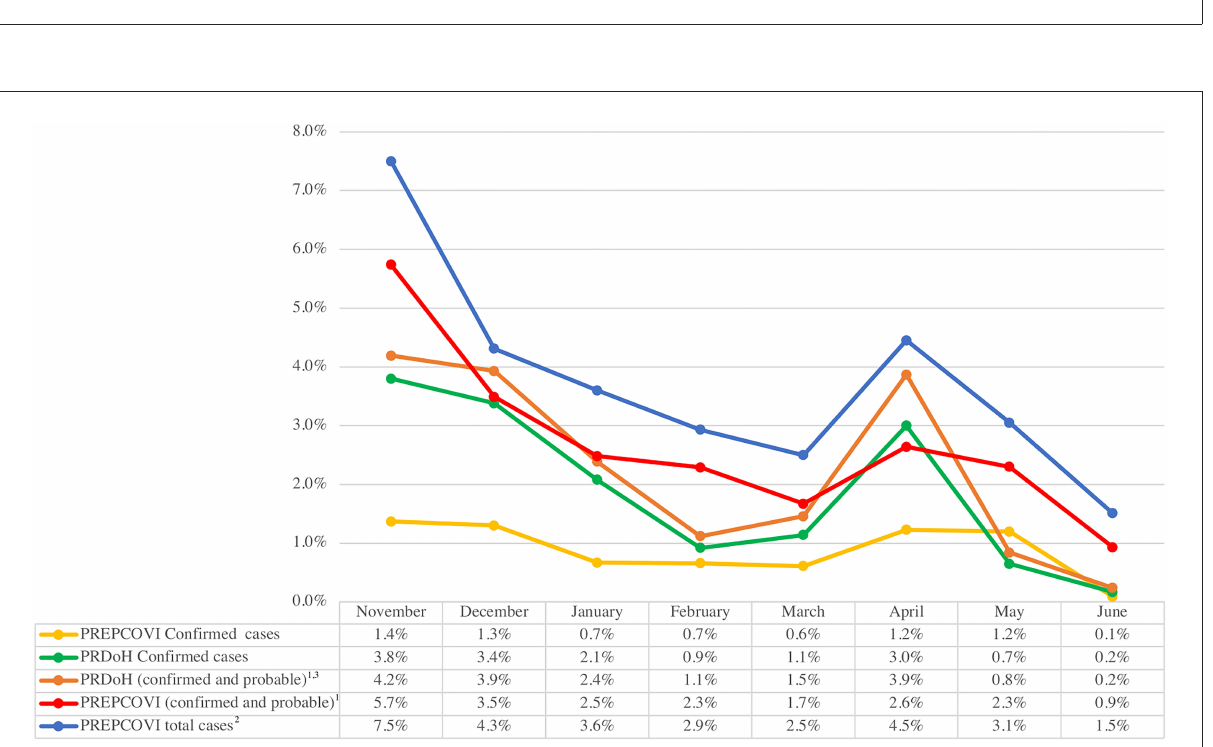
FIGURE4 Comparison of PREPCOVI and PRDOH COVID-19 from November 2020 to June 2021 (both cases were standardized to the age and sex distribution of the PR census). 1 Confirmed cases are based on the PCR test, and probable cases are based on other tests. 2 PREPCOVI total cases include confirmed, probable, and cases based on the model using key symptoms. 3 PRDOH months are consistent with the test dates, whereas PREPCOVI months include the last 30 days of the survey for each participant (i.e., 1 month period for each participant, but the exact dates vary across participants and between PRDOH and